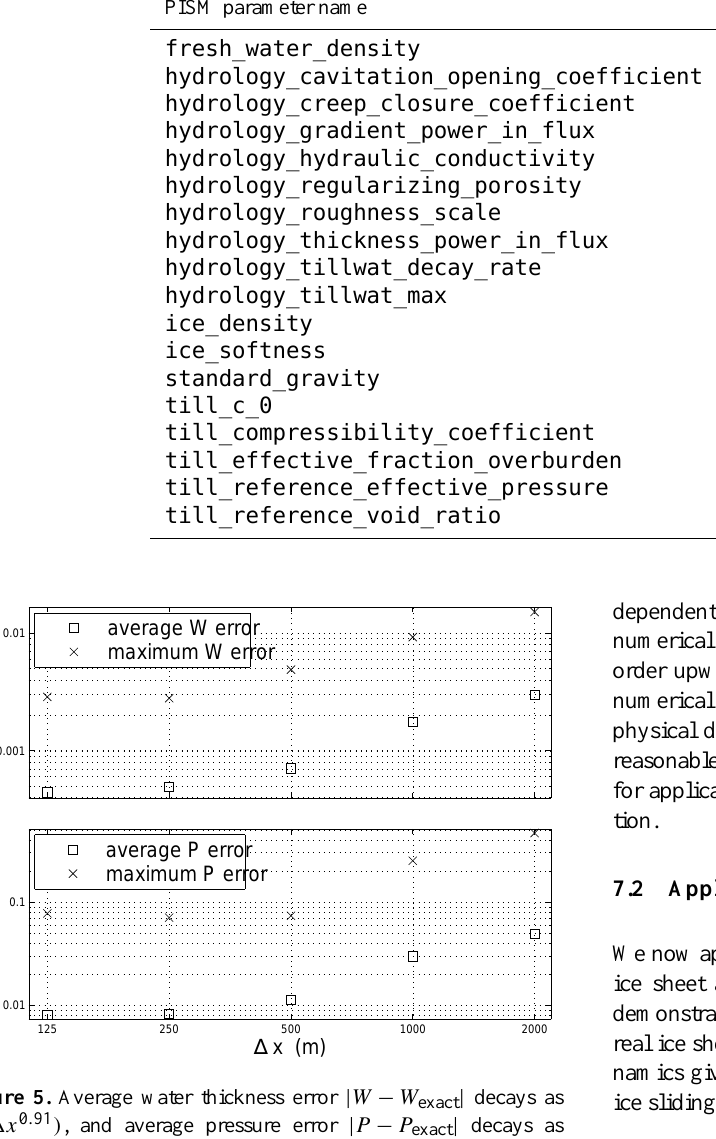
roughly linear (i.e., about O((cid:49)x 1 ) ) because the largest